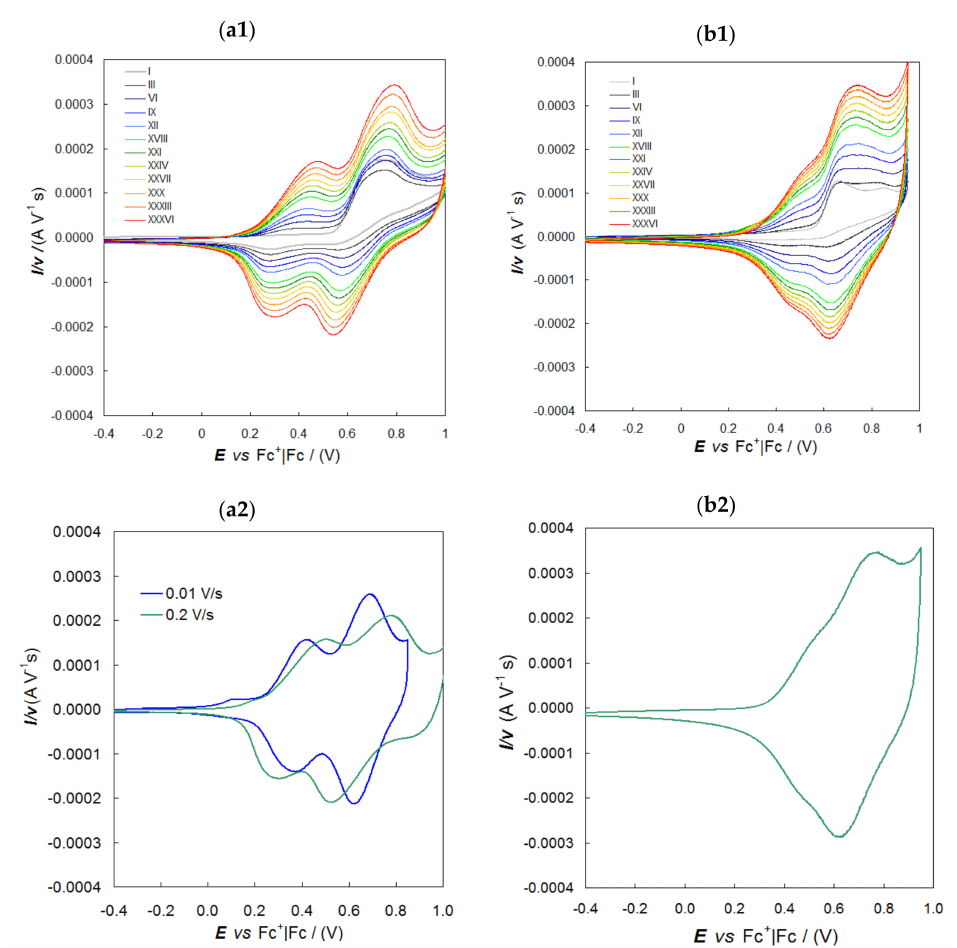
Figure 8. Electrooligomerization of 0.00075 M ( R )-Naph 2 T 4 monomer on a GC tip electrode in dichlorometane (CH 2 Cl 2 ) ( a1 ) and acetonitrile (CH 3 CN) ( b1 ). In both cases, 0.1 M TBAPF 6 was used as the supporting electrolyte and oxidative potential cycling was carried out at 0.2 V s − 1 . The last stability cycle in monomer-free solution, in CH 2 Cl 2 ( a2 , comparing two di ff erent scan rates) and in CH 3 CN ( b2 , at 0.2 V s − 1 potential scan